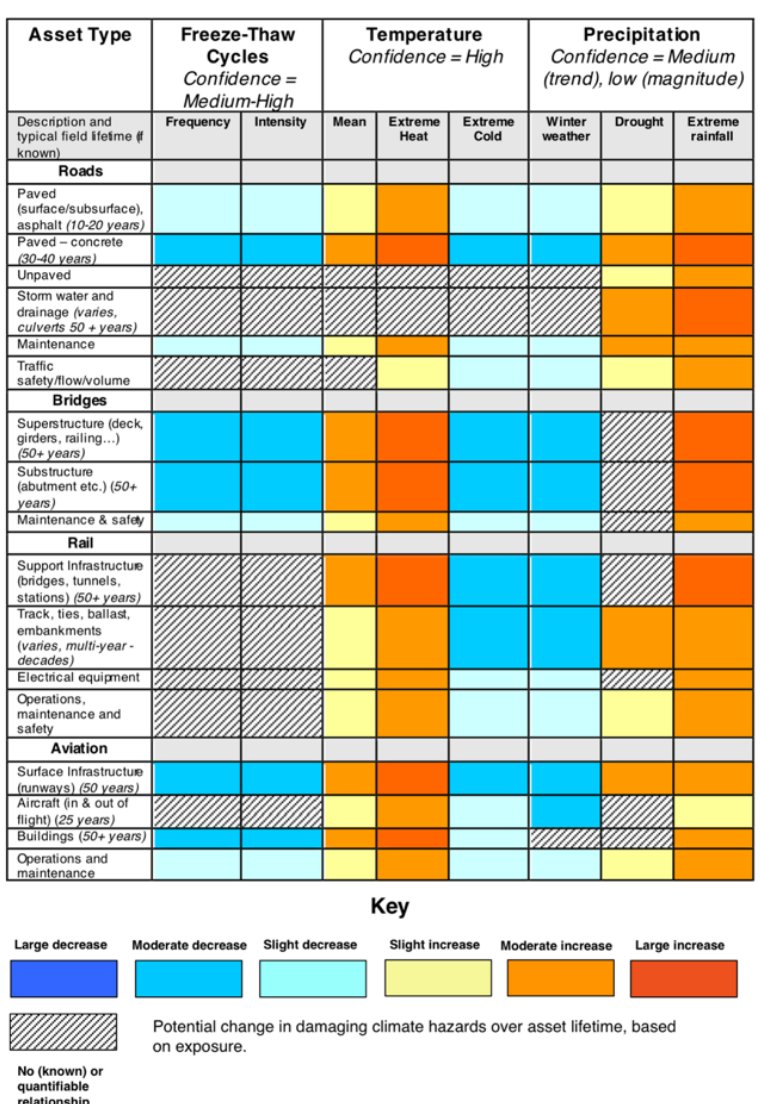
Figure 10. ‘Sensitivity Matrix’ for central Oklahoma, based on Rowan et al. [9] and available as a template through the resiliency toolkit of the U.S. Federal Highway Administration. The left column lists infrastructure assets and the shaded boxes denote the relative magnitude and direction of projected change associated with the climate criteria described in Section 4.2. Impact is therefore only a function of potential exposure to climate hazards. Diagonal hatching indicates unknown or negligible impacts. Confidence (top row) is based on the general framework from Mullens and McPherson [42] and is based on the availability of research and agreement among findings.